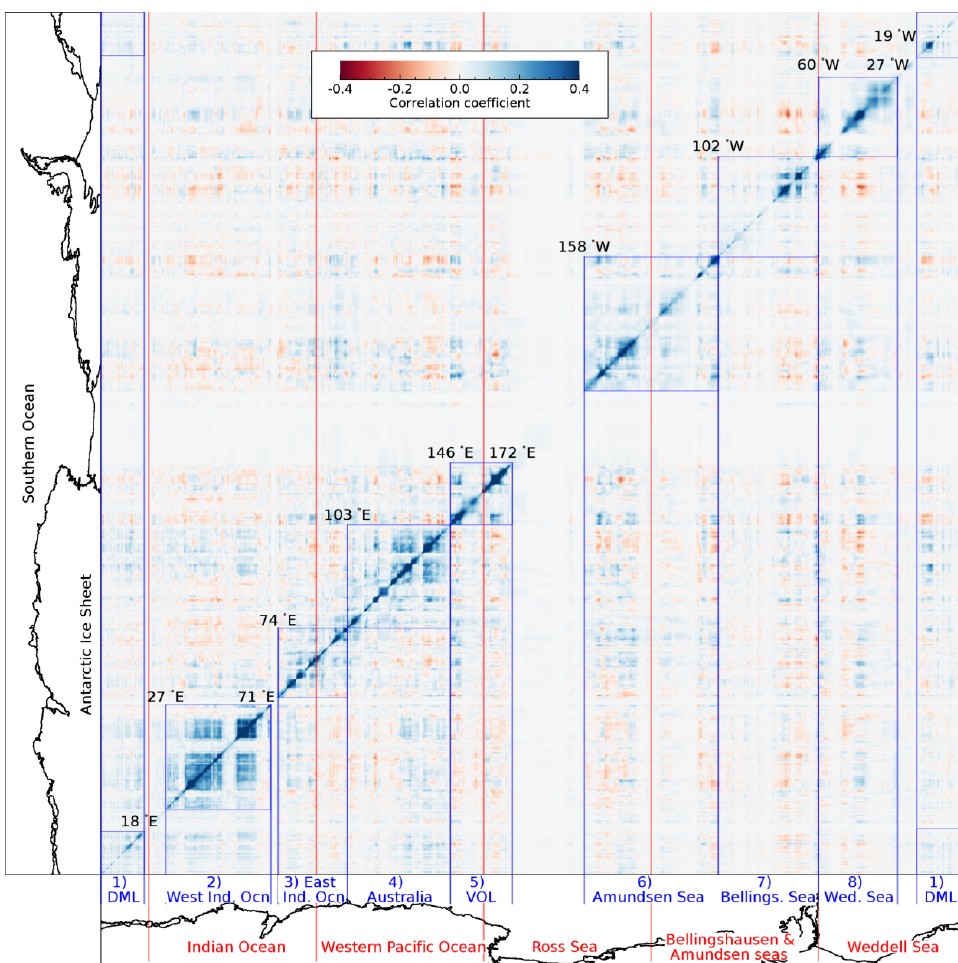
Figure B1. Fast-ice anomaly cross-correlation matrix. Red vertical lines indicate the traditional sea-ice sectors. Blue vertical lines and blue- outlined boxes highlight fast-ice regions consisting of pockets of high cross-correlation, indicating regions which co-vary. DML is Dronning Maud Land and VOL is Victoria and Oates Lands.